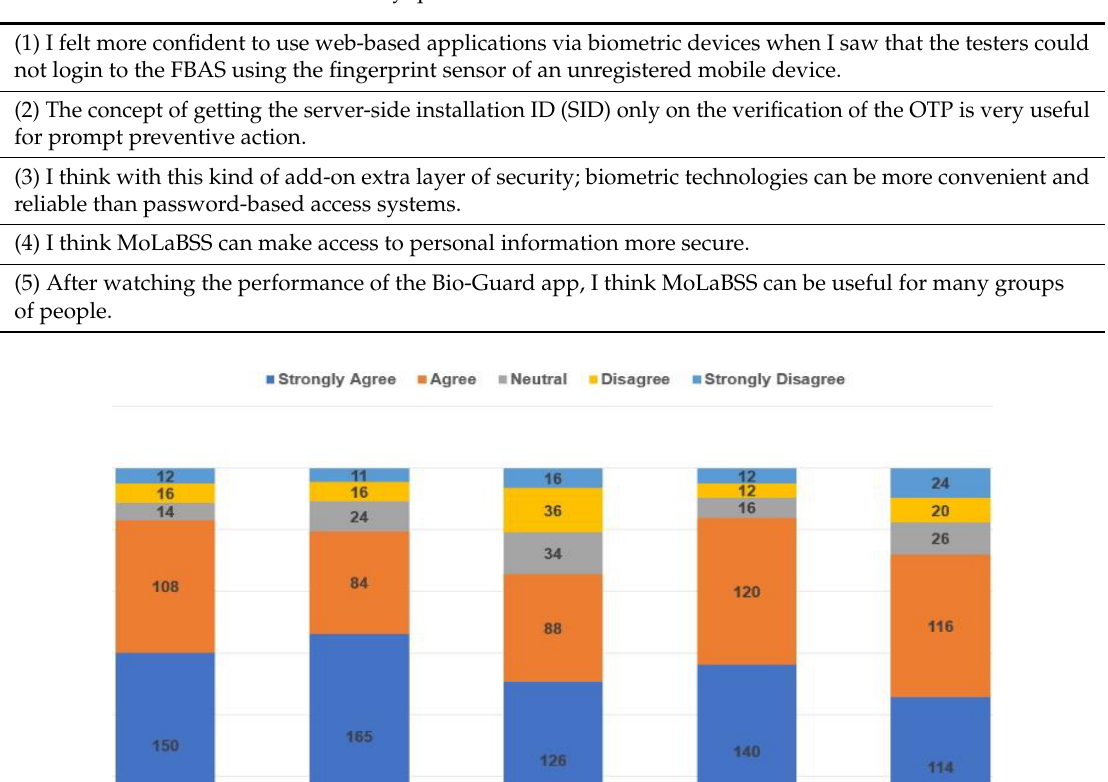
Table 4. Survey questions to test the success of the MoLaBSS.